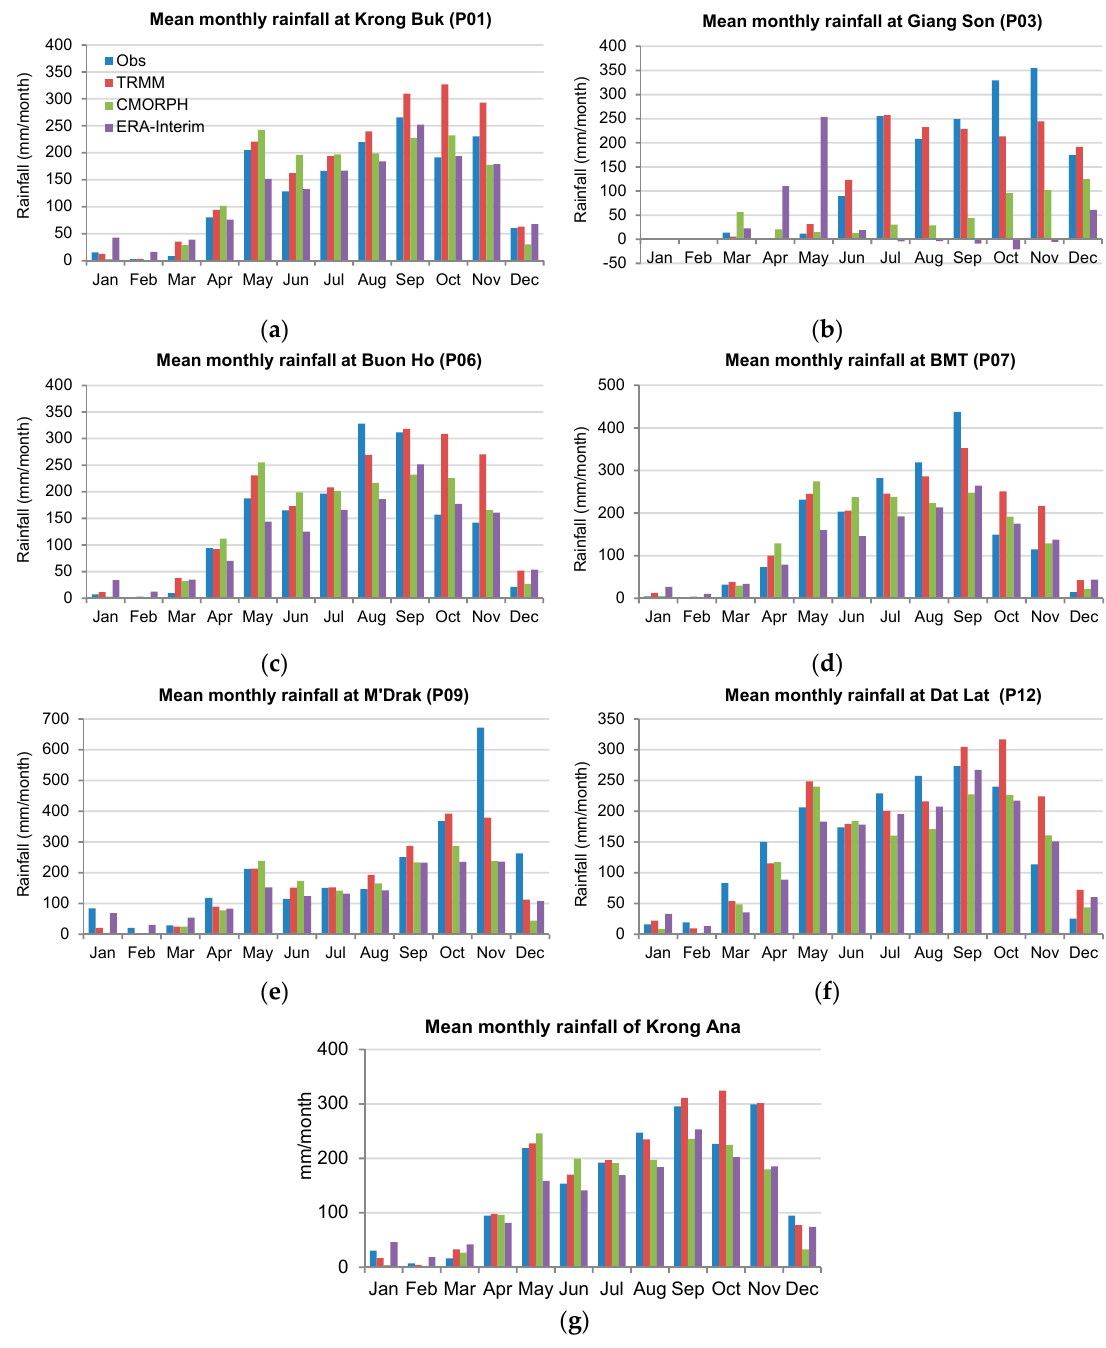
Figure 4. Comparison of average monthly rainfall patterns (2003–2010) from different data sources at different stations and Krong Ana Sub-catchment: ( a ) at Krong Buk station (P01), ( b ) at Giang Son station (P03), ( c ) at Buon Ho station (P06), ( d ) at BMT station (P07), ( e ) at M'Drak station (P09), ( f ) at Dat Lat station (P12), and ( g ) at Krong Ana Sub-catchment.